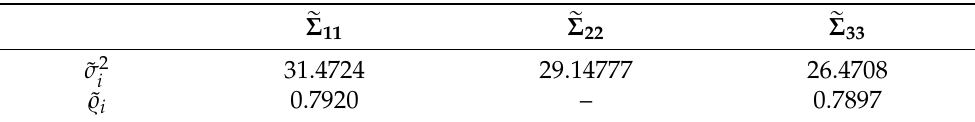
Table 2. Parameter values of